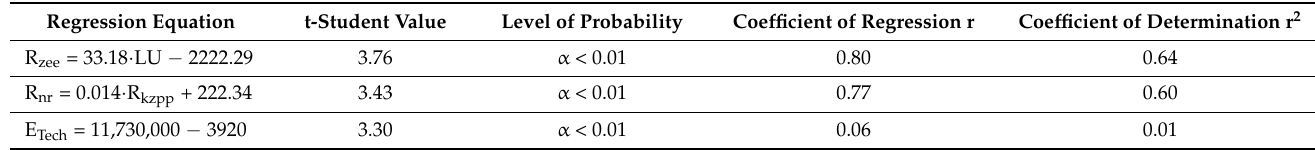
Table 10. Selected statistical dependencies based on linear